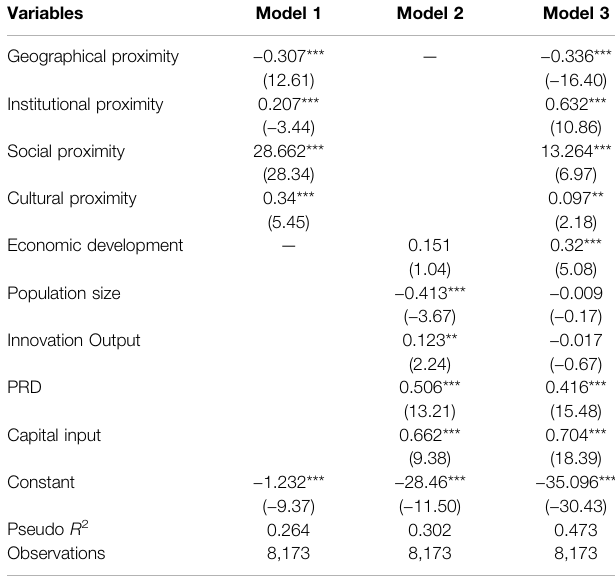
TABLE 3 | Regression results of urban network in fl uence